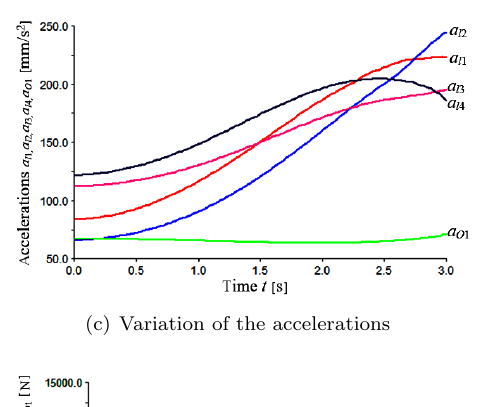
Figure 7: The kinematics and dynamics results of the GHMT